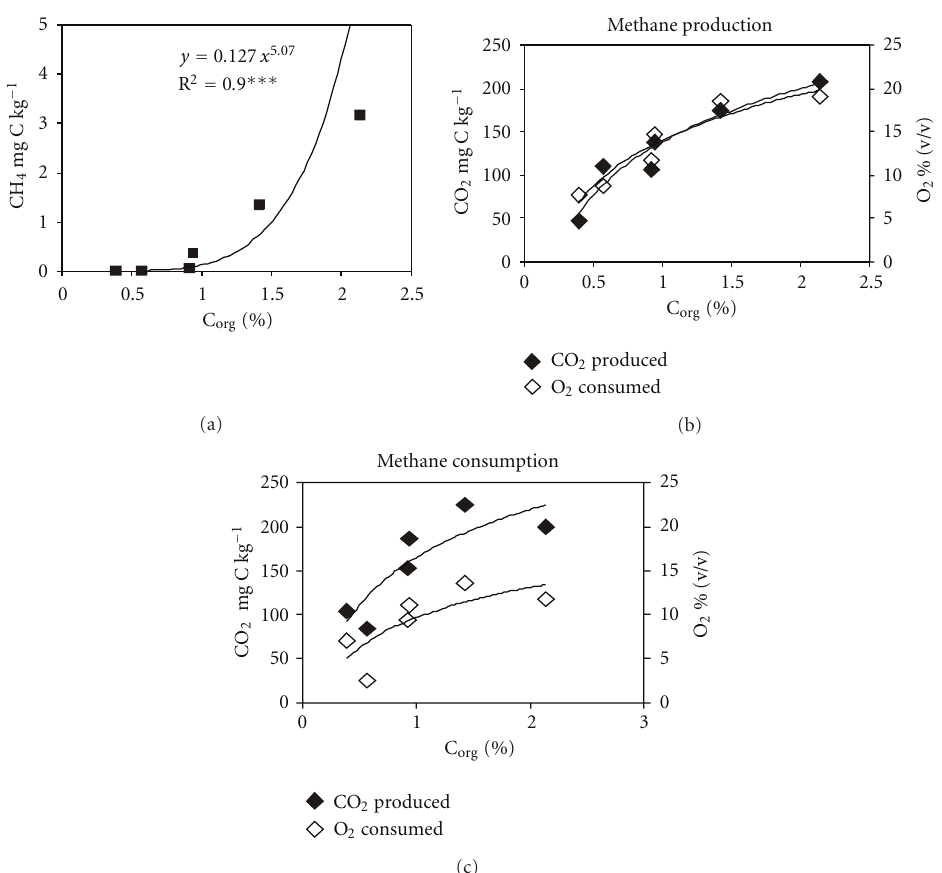
Figure 3: Relationships between total gases produced or consumed over time and organic carbon (C org ) in soils collected from di ff erent slope positions. (a) CH 4 produced in flooded soils versus C org ; (b) CO 2 produced and O 2 consumed in flooded soils versus C org ( y = 7 . 60 · Ln( x ) + 14 . 1, R 2 = 0 . 92 ∗∗∗ ) and ( y = 88 . 4 · Ln( x ) + 138 . 7, R 2 = 0 . 93 ∗∗∗ ); respectively, (c) CO 2 produced and O 2 consumed in wet soils enriched with CH 4 soils versus C org ( y = 78 . 1 · Ln( x ) + 165 . 2, R 2 = 0 . 74 ∗∗∗ ) and ( y = 4 . 38 · Ln( x ) + 4 . 60, R 2 = 0 . 92 ∗ ), respectively. Points present mean values. ∗∗∗ and ∗ , P < 0 . 001 and P < 0 . 05, respectively.